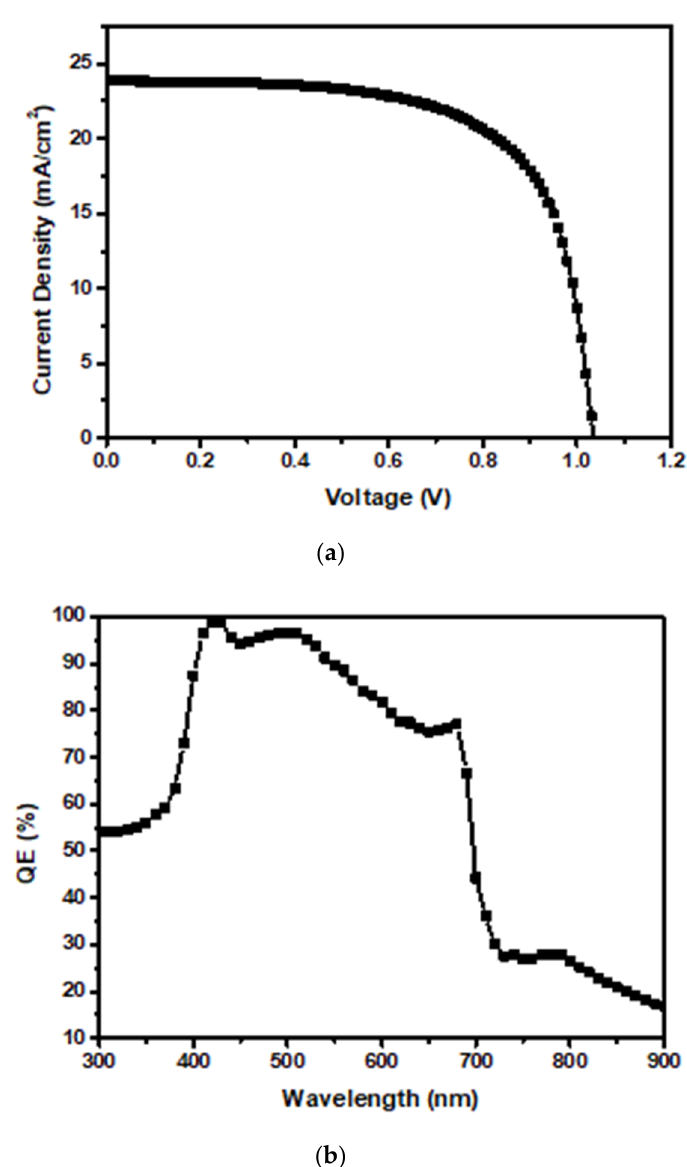
Figure 2. ( a ) Current density–voltage ( J–V ) and ( b ) quantum efficiency (QE) curve for ITO/ZnO/CsP- bI x Br 3−x /NiO x /Au structure.